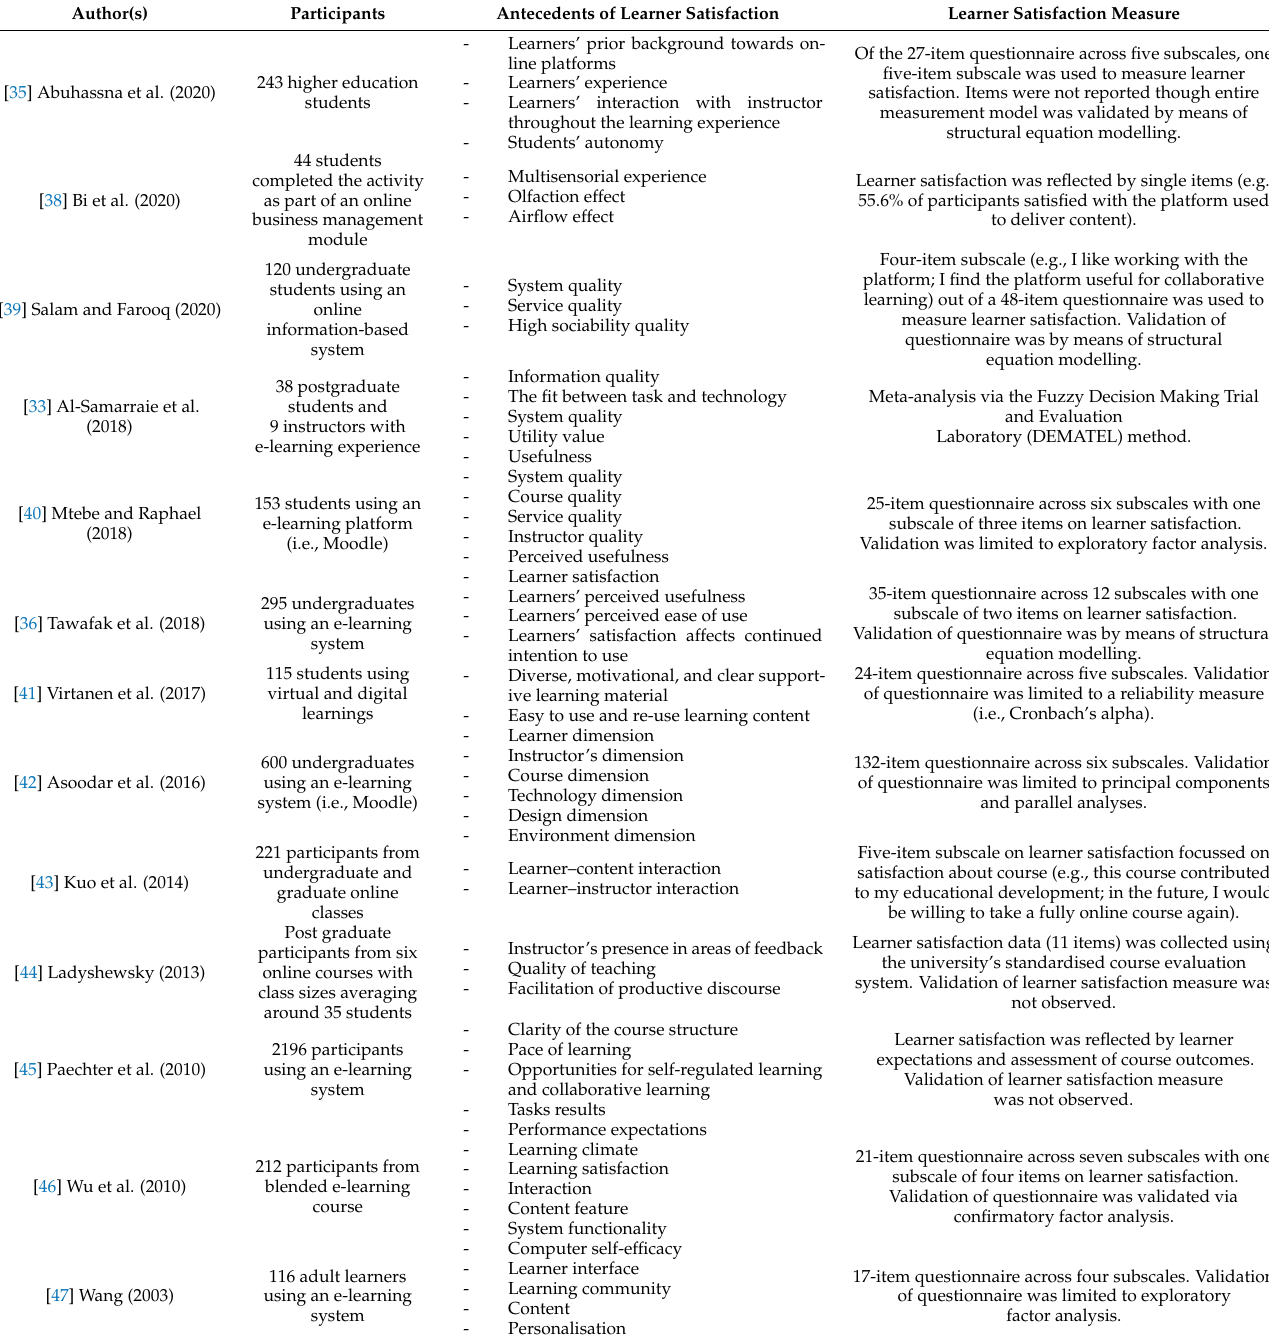
Table 1. Studies of antecedents of learner satisfaction in chronological